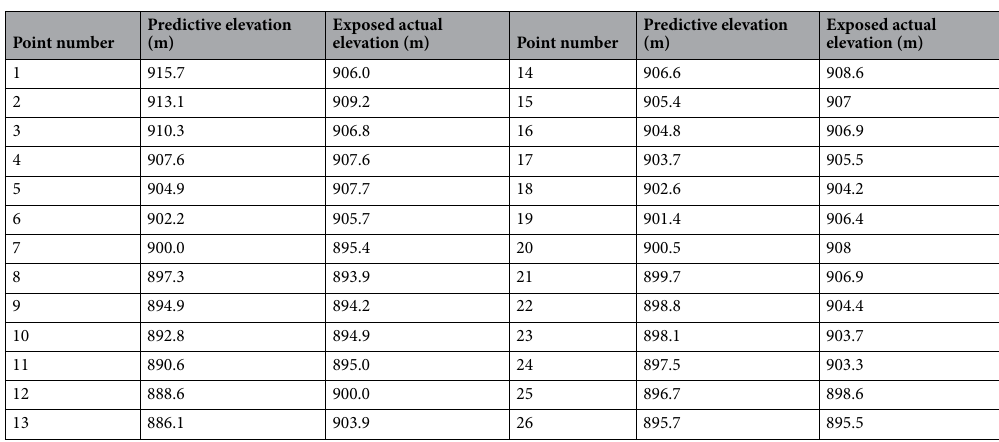
Table 2. Exposed actual value and predictive elevation calculated based on surface spline